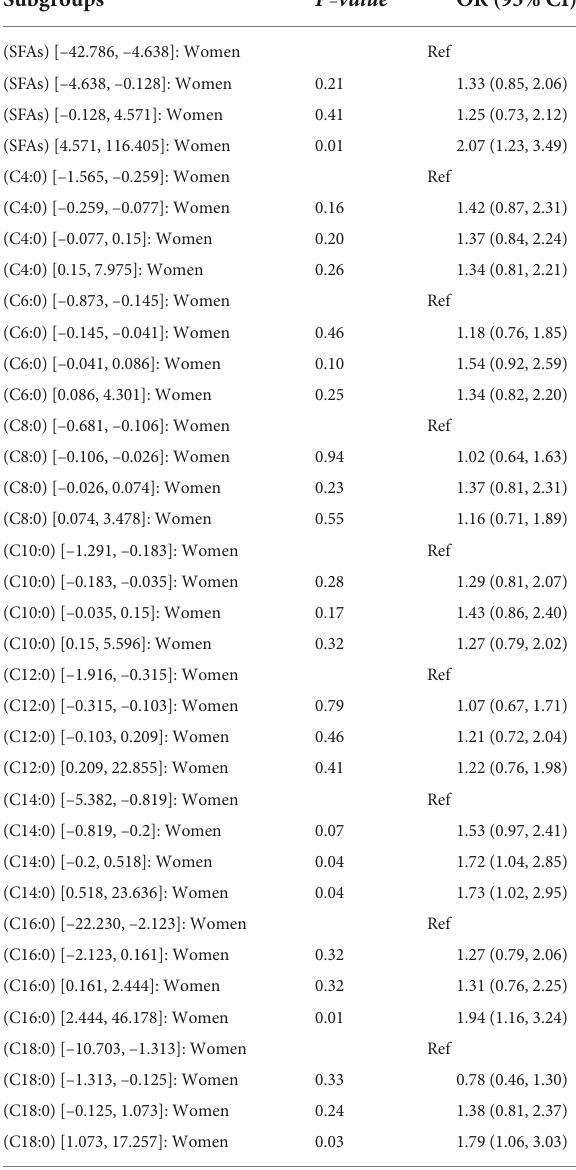
TABLE 8 OR (95% CI) for hypertension in quartiles of adjusted intake of dietary saturated fatty acids and their subtypes interacted with sex in NHANES,